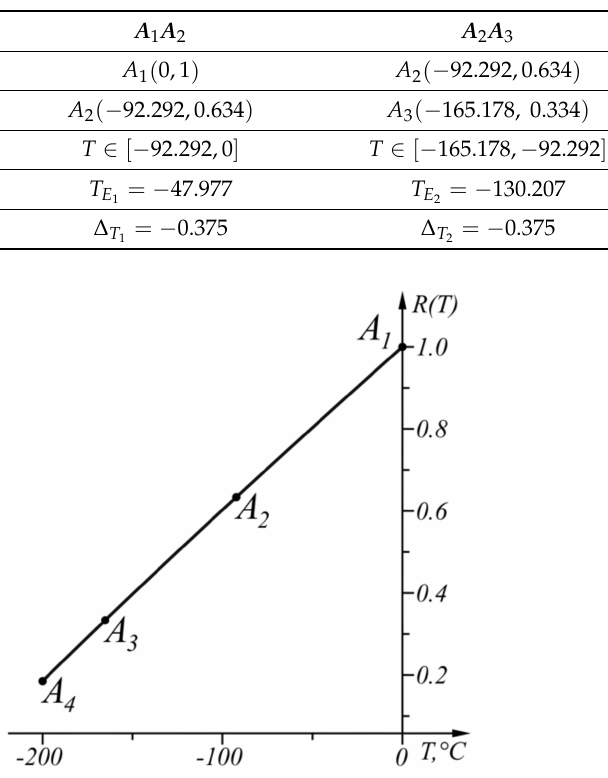
Table 3. Results in the range T ∈ [ − 200, 0 ] ◦ C.